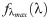
Graphs of fλmax(λ), g(λ) and the translation with d1 = 10.4 for W˜(3,13).